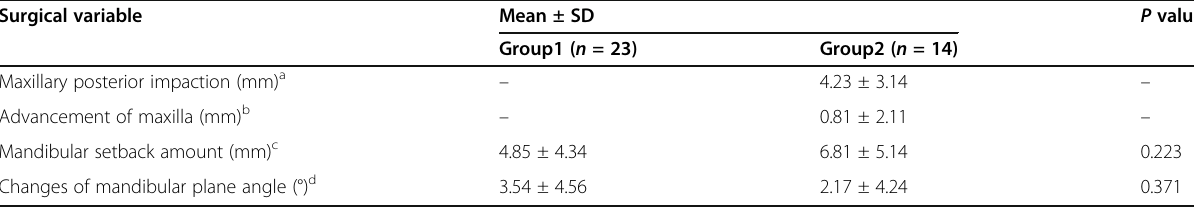
Table 1 Surgical movement of group 1 and group 2 Surgical variable